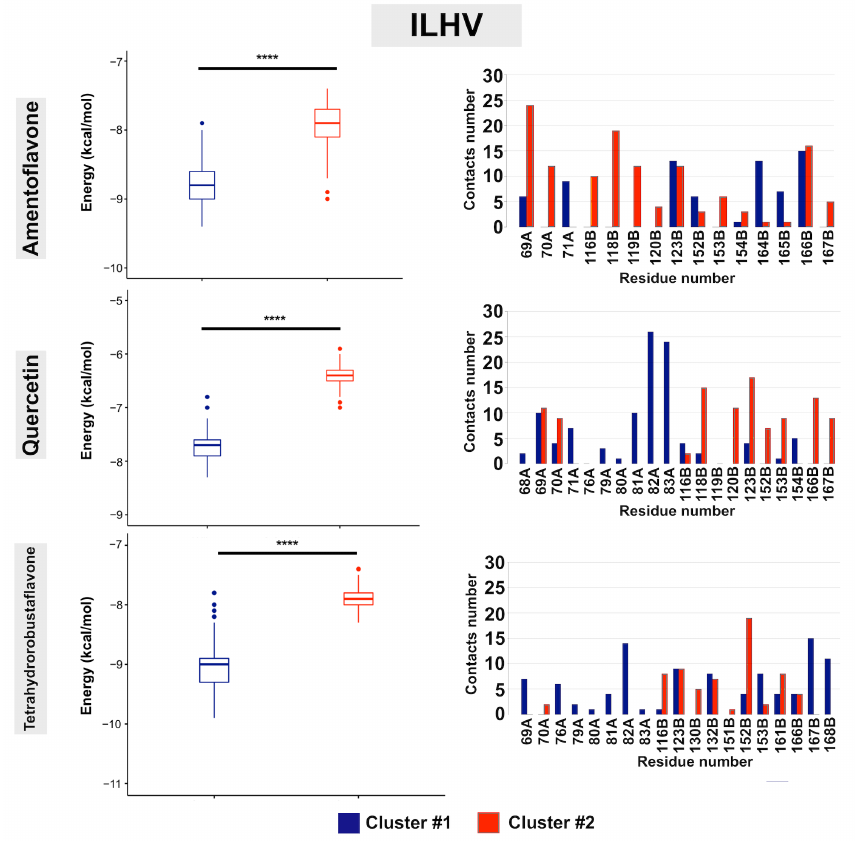
Figure 5. Comparison of energy distribution between Ilhéus (ILHV) clusters and bar graph of number of contacts per residue of NS2B and NS3pro protein complex. Chains A and B are NS2B and NS3pro, respectively. **** p <